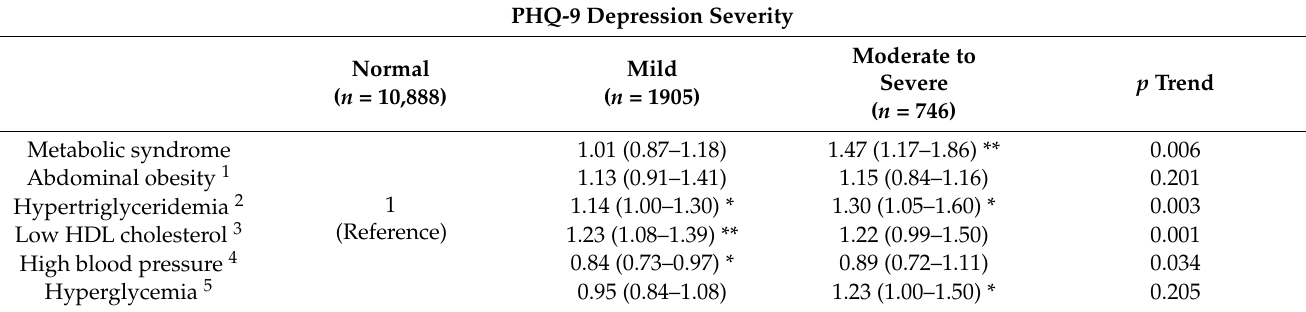
Table 7. Adjusted odds ratios (95% confidence intervals) for risks of metabolic syndrome and its components of subjects according to depression